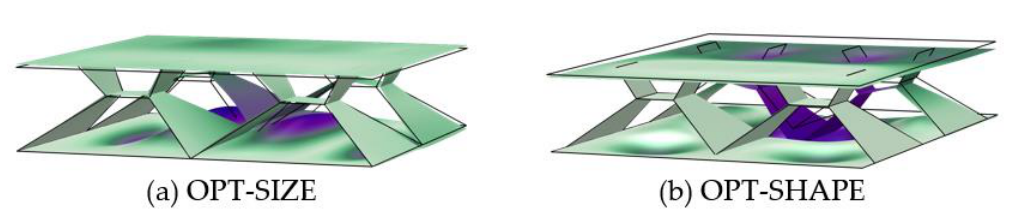
Figure 13. Buckling mode of ( a ) OPT-SIZE and ( b ) OPT-SHAPE at Time 3.